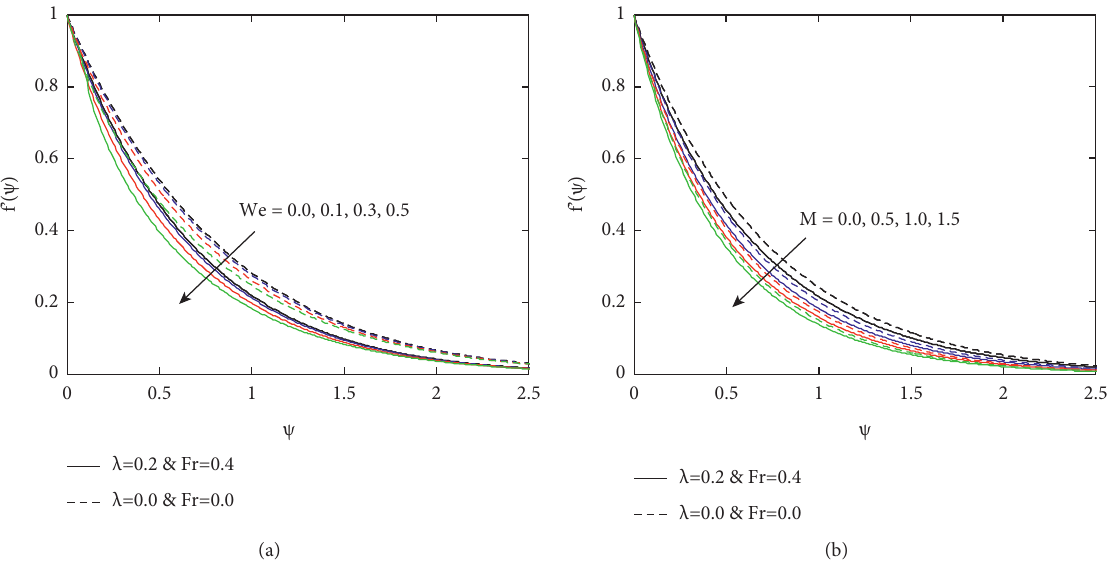
Figure 1: The velocity distribution for diverse quantity of We (a) and M (b).